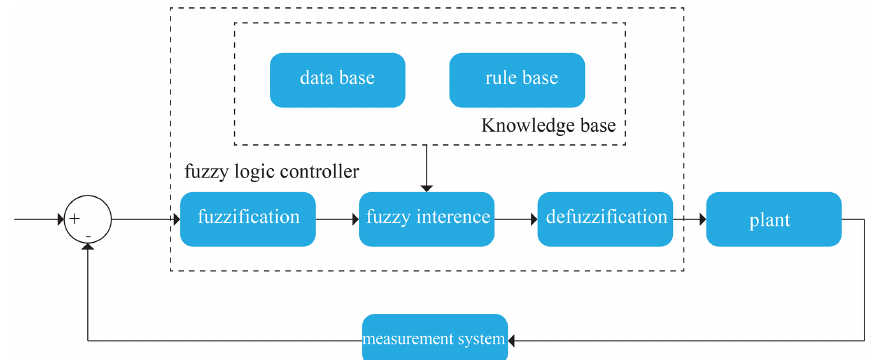
Figure 7. The fuzzy logic controller.